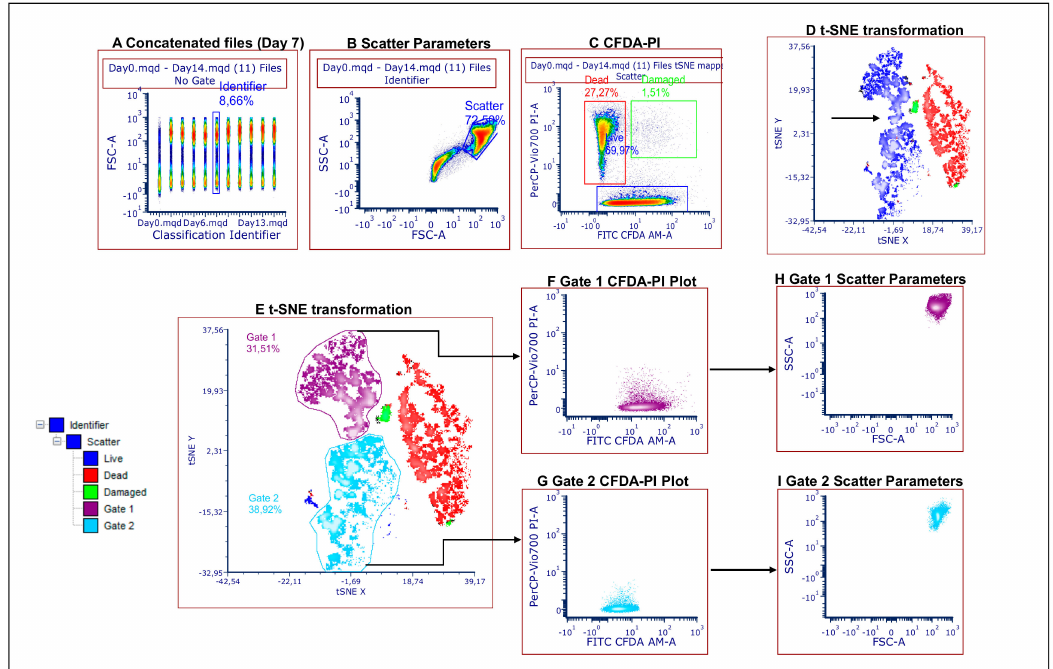
Figure 6. Unsupervised analysis and exemplative t-SNE and 2D plots from day 7. ( A ) All FCS files are concatenated in a single file for t-SNE analysis. The results from day 7 are further displayed (see events in the “Identifier” gate). ( B ) Scatter dot plot. ( C ) Dot plot identifying live, dead and damaged cells by CFDA-PI staining. ( D ) The t-SNE transformation plot. Note that the main populations from ( C ) are easily identifiable in the t-SNE plot: blue cluster = live cells, red cluster = dead cells and green cluster = damaged cells. ( E ) The t-SNE plot and gating of two subclusters. ( F – I ) The CFDA-PI and scatter profiles of cells within gates 1 and